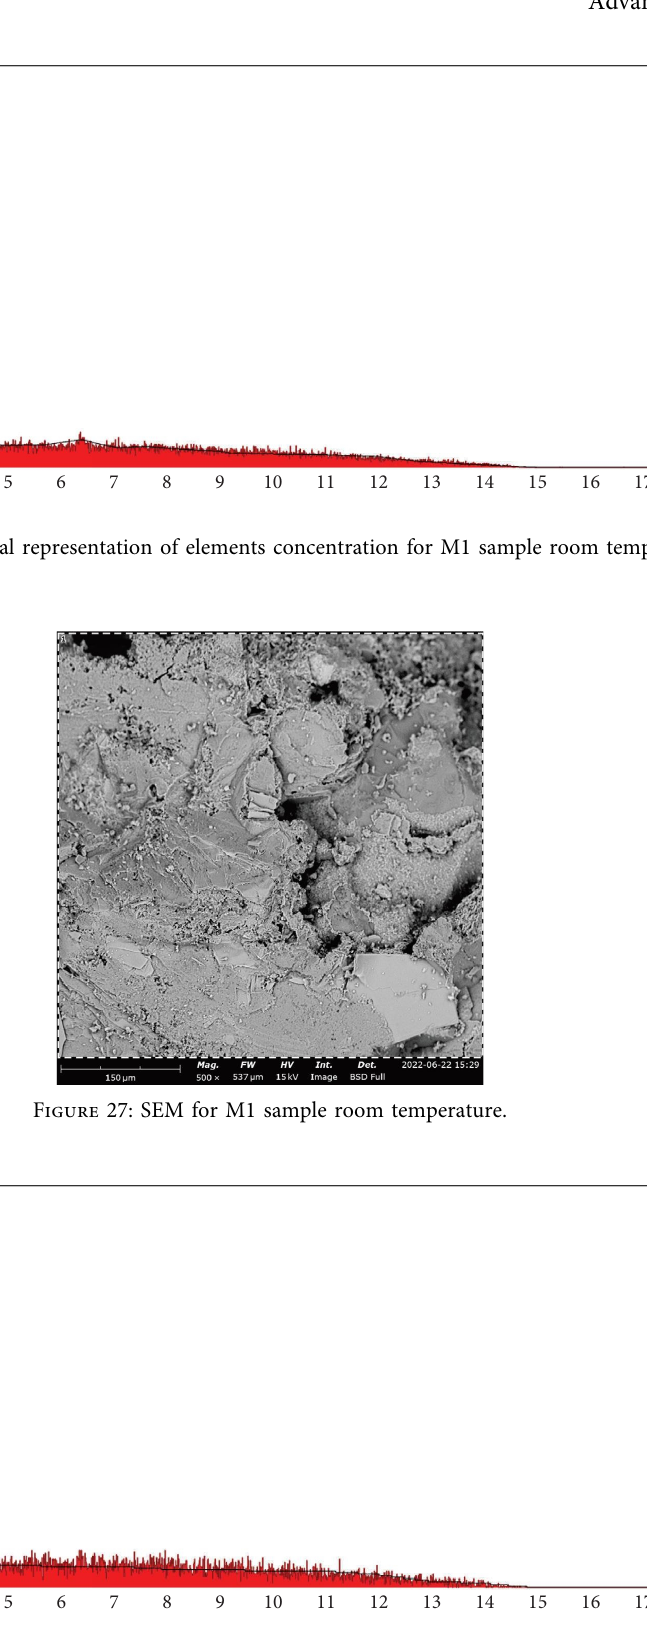
Figure 28: Graphical representation of elements concentration for M2 sample 800 °